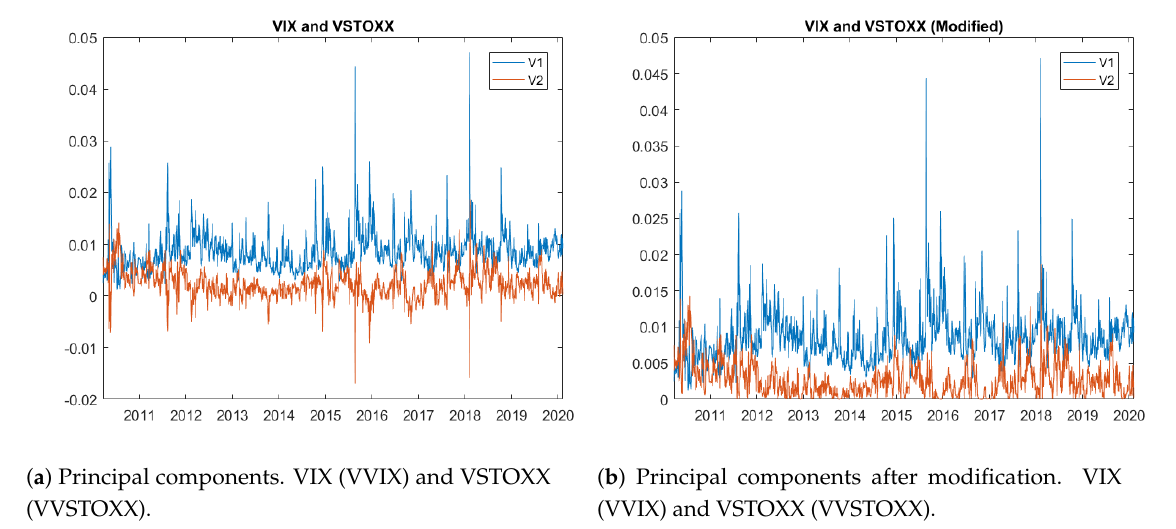
Figure 4. Principal components with volatility indexes’ data.